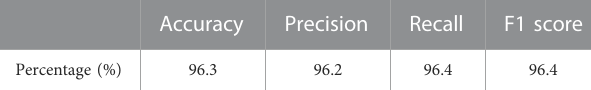
TABLE 8 Precision, recall, and F1-score